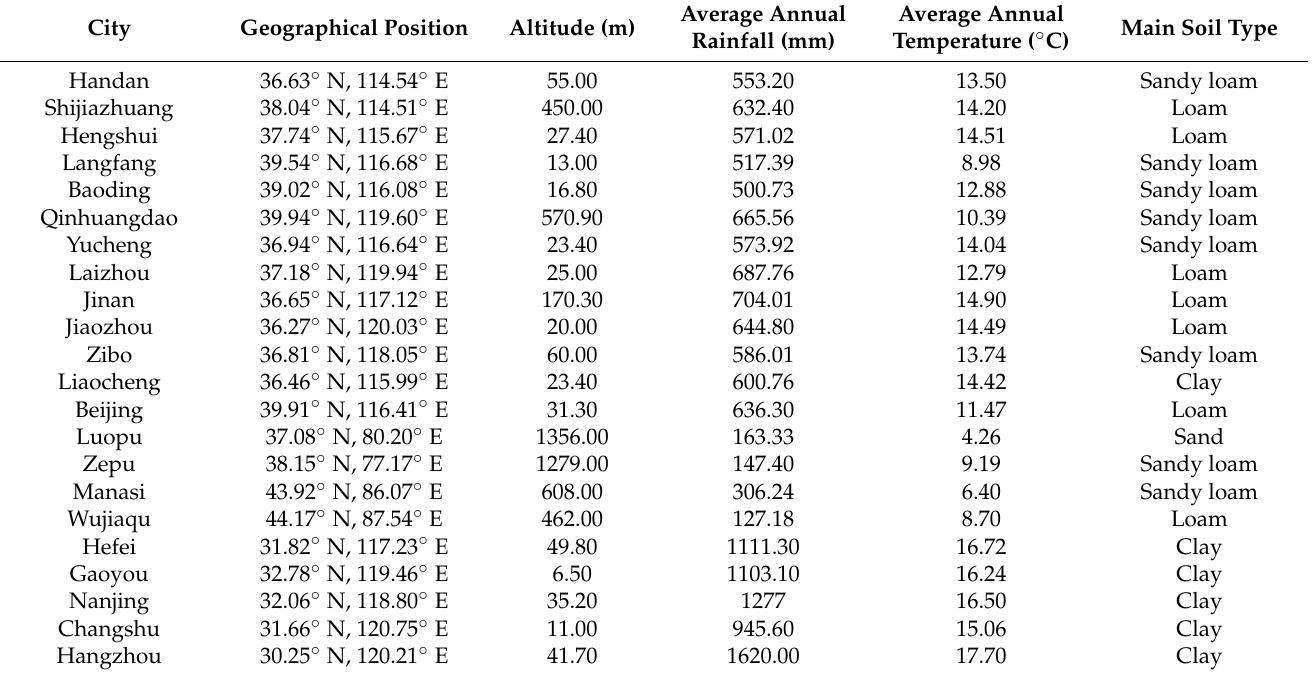
Table 1. Geographical Position and Main Characteristics of Each Site of Winter Wheat in China.